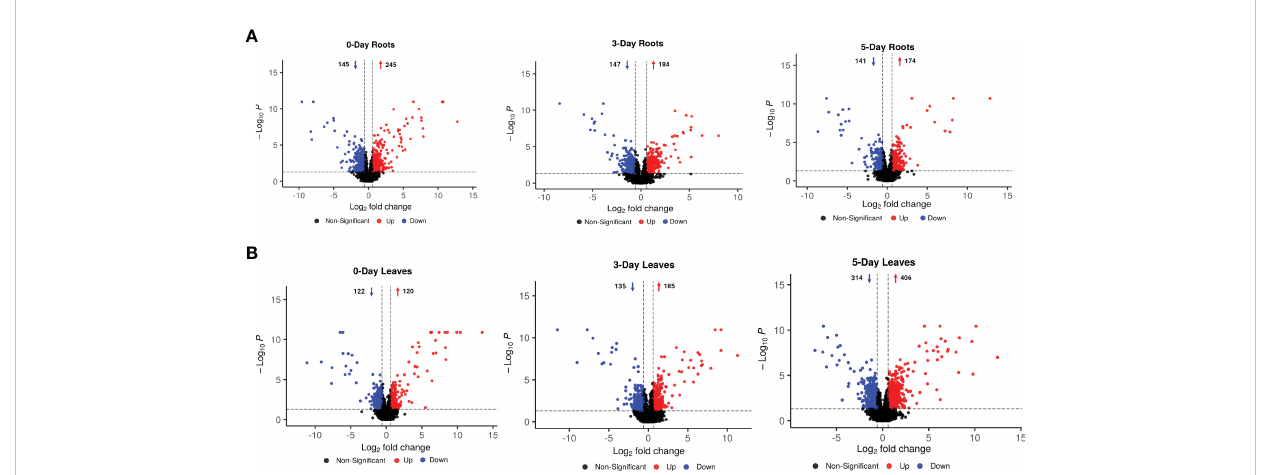
BA FIGURE 3 Volcano diagram analysis for metabolites that were signi fi cantly changed in accumulation and were fi ltered by using the criteria of p-value < 0.05 and log 2 FC > 0.6 or < -0.6 (between SWE-treated and non-treated samples in the same tissue at one time point) in 0-, 3- and 5-day roots (A) and leaves (B) . Red and blue color represent the increased and decreased accumulation of metabolites, respectively. The arrows and numbers represent the number of metabolites that were increased and decreased in accumulation, respectively. Data presented are from six replicates with three individual experimental